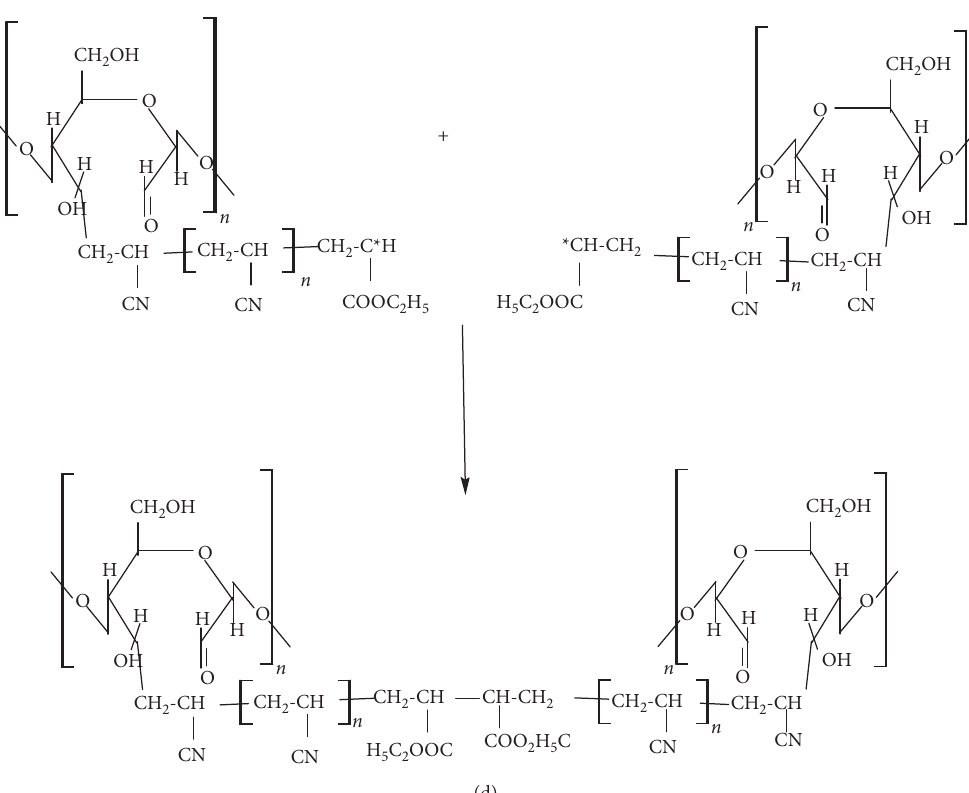
Scheme 1: The proposed mechanism for grafting. (a) Radical generation. (b) Chain initiation. (c) Chain propagation. (d) Chain termination.